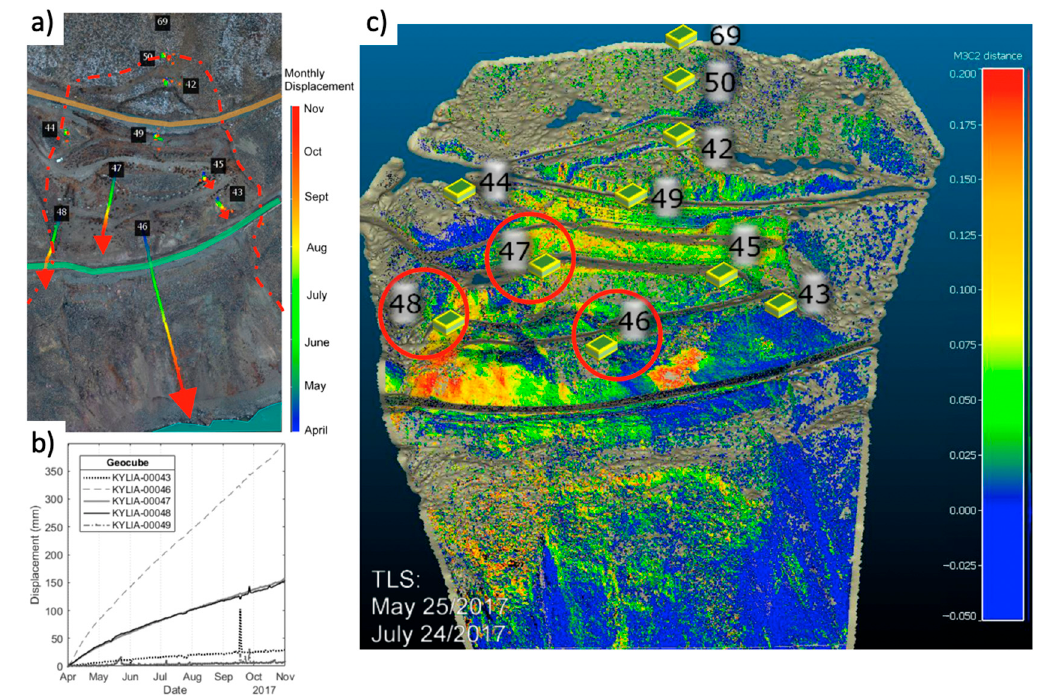
Figure 7. Location of GPS units and displacement vectors at a scale of 1:500 ( a ), cumulative displacements of selected units ( b ), and TLS Change Detection between May and July 2017 ( c ) After [41].